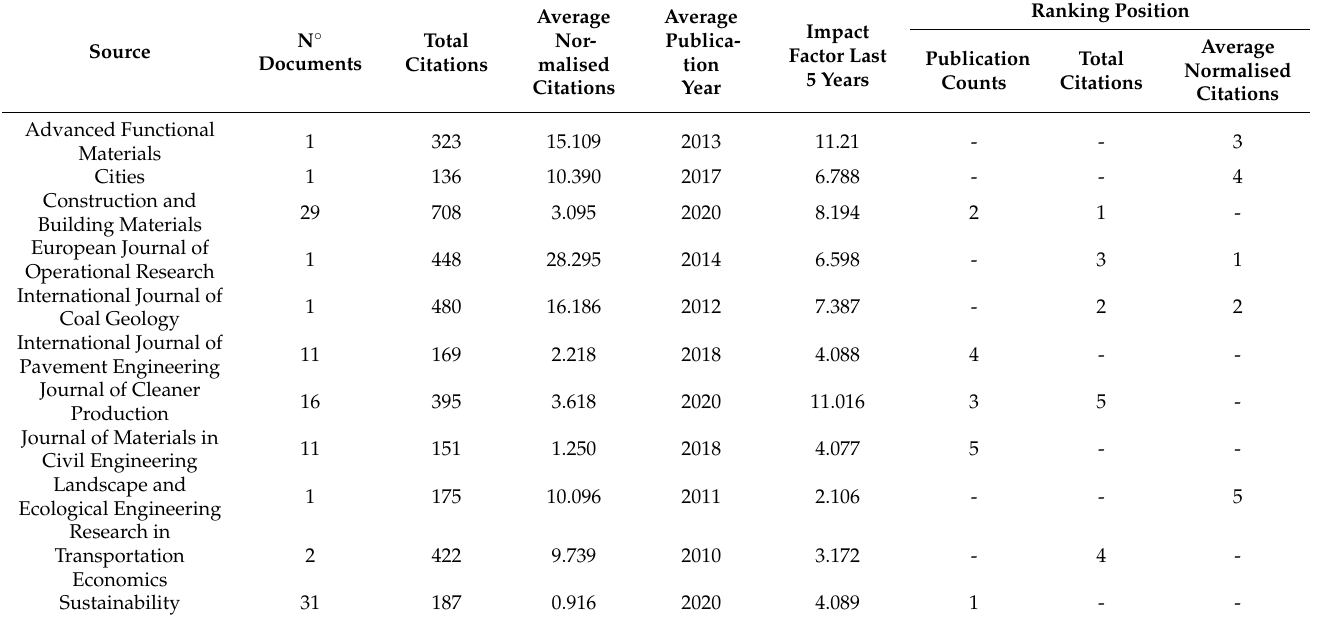
Table 1. Main sources of publication in terms of publication count, total citations and average normalised citations, and source quality.